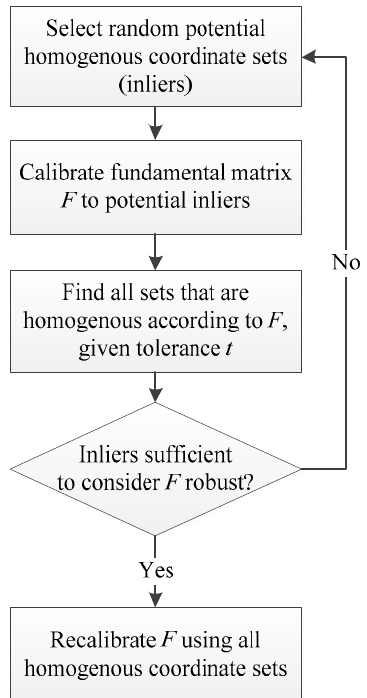
Figure 3. RANdom SAmple Consensus (RANSAC) algorithm for estimating homologous coordinate sets of corresponding points in a stereo image pair.